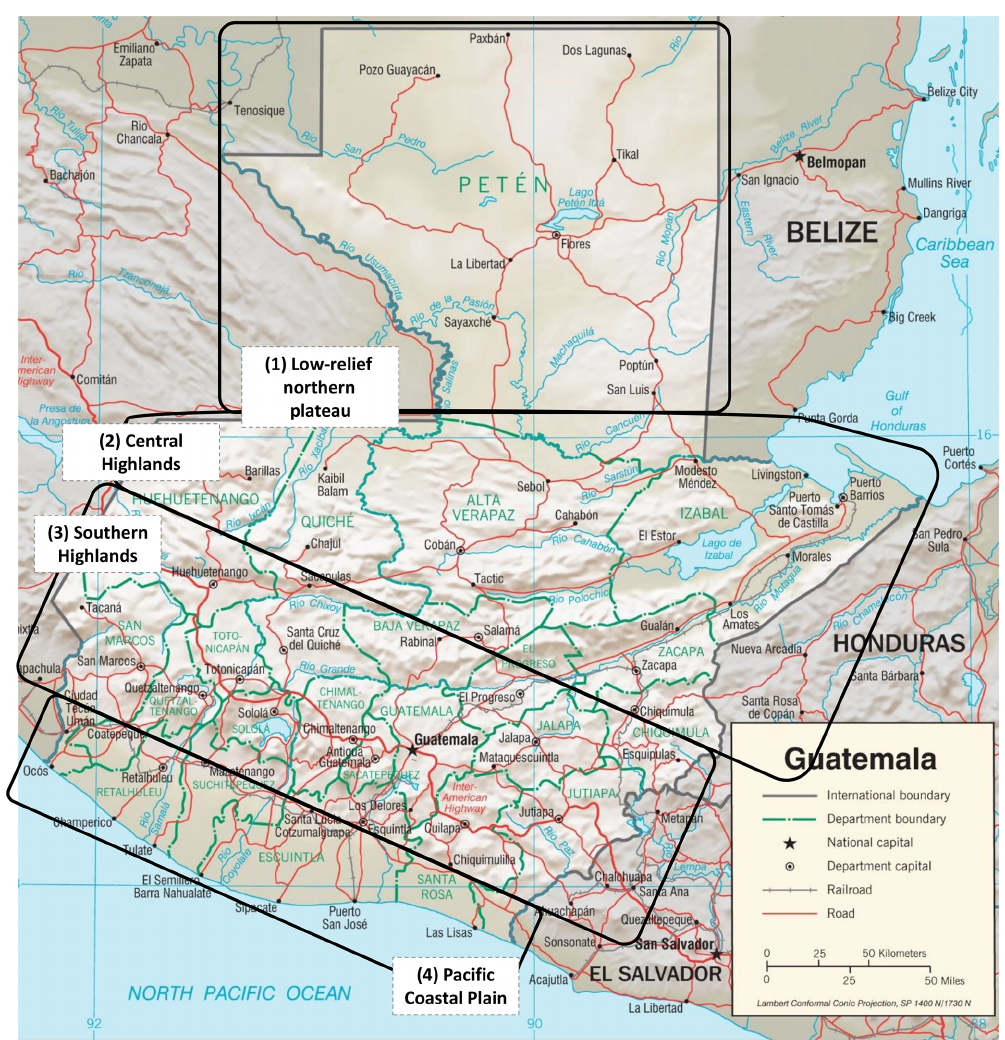
Figure 1. Guatemala map: key locations and physiography, using CIA (2001) Base 802723AI (C00113) 12-00. A combined political and physiographic map of Guatemala, showing differential relief (greyscale shading), departmental boundaries (green lines and text), key loca- tions (black text), rivers (blue lines and text), and roads (red lines). We group Guatemala into four broad regions (1–4) based on physiography. We refer particularly to the southern Guatemalan Highlands (region 3) throughout this